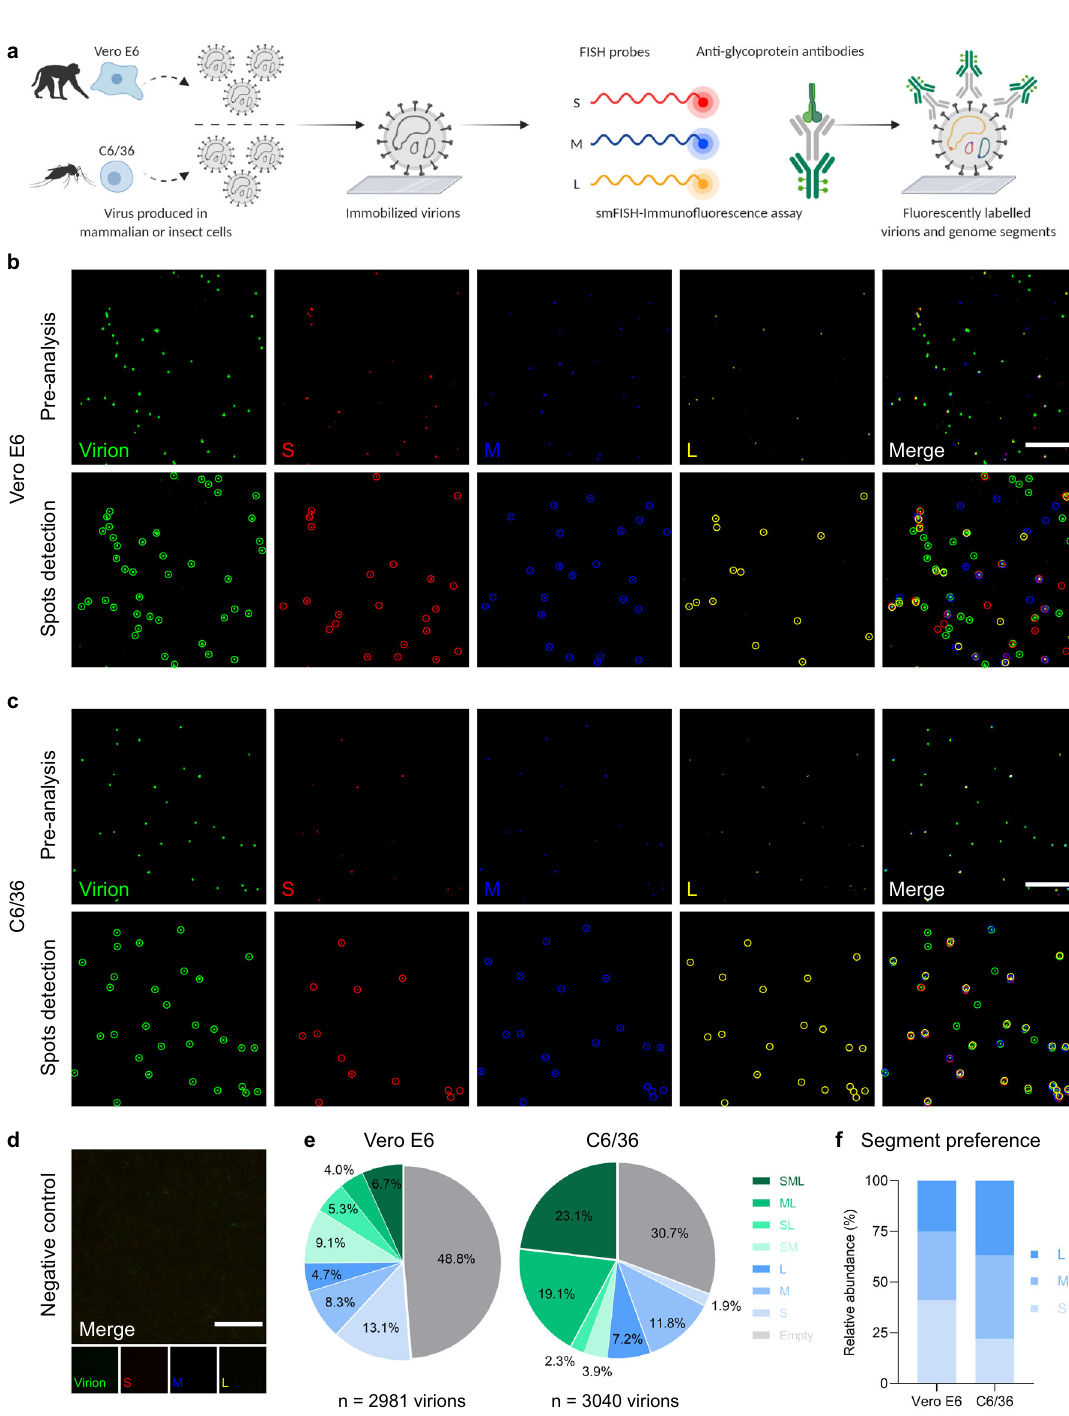
Fig. 5 Genome segment composition of immobilized RVFV virions produced in mammalian and insect cells. a Schematic representation of the experimental setup. RVFV virions produced in Vero E6 cells or C6/36 cells were immobilized on coverglass by incubation for 5 h at 28 °C. The S segment (N gene; red), M segment (NSmGn and Gc genes separately; blue) and L segment (RdRp gene; yellow) were hybridized using probe sets labeled with CAL Fluor Red 610, Quasar 670 and Quasar 570, respectively. Progeny RVFV particles (green) were detected with antibody 4-D4 48 targeting the Gn glycoprotein in combination with Alexa Fluor 488-conjugated secondary antibodies. Individual spots, each representing either a single vRNP or a virus particle were detected, counted and assessed for co-localization in ImageJ with the plugin ComDet. Visualization of RVFV virions produced in Vero E6 cells ( b ) or C6/36 cells ( c ) (top rows). Merge images show the overlay of the four individual channels. Colored circles (bottom rows) display the spots detected on each channel and their co-localization in the merge image. Due to a higher fl uorescence intensity of the green channel compared to the other channels, spots co-localizing with the glycoprotein may sometimes appear masked and not entirely evident in merged images. d Negative control sample using cell culture media instead of a virus stock preparation. Scale bars, 5 µ m. e Relative abundance of the eight possible genome compositions of the virions produced in Vero E6 cells (left) or C6/36 cells (right). f Abundance of each genome segment incorporated into a virion relative to the total genome segment packaging